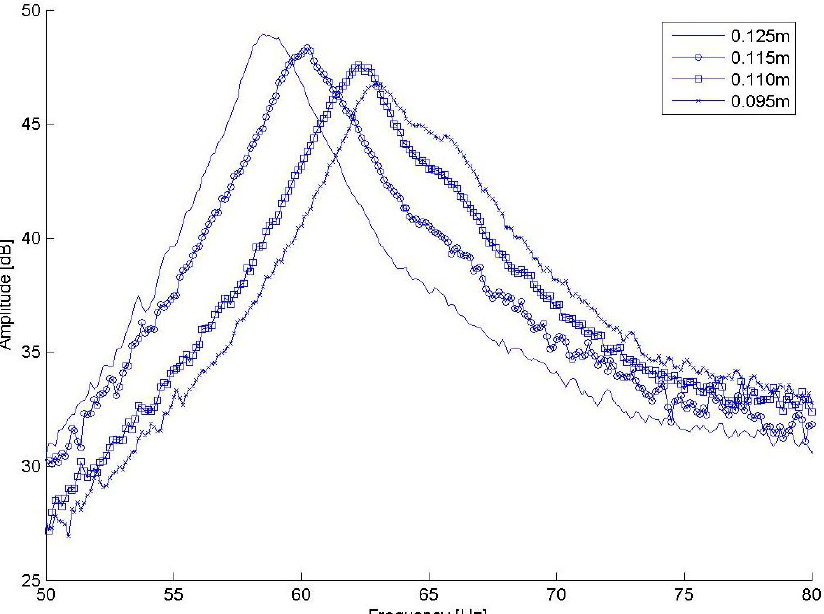
Figure 6. Amplitudes of the FRFs for different positions of the bolt along the tuning